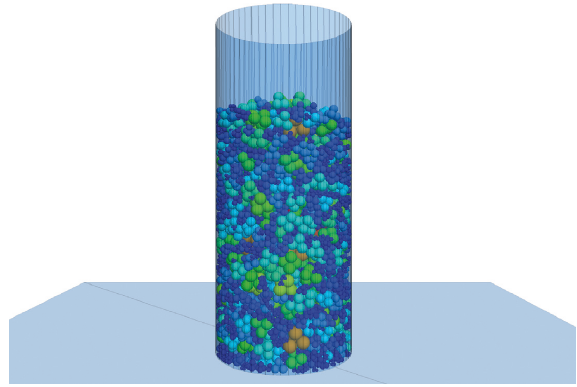
Figure 8: DEM model of 4-ball particles in a bottom-opened cylinder prepared to be